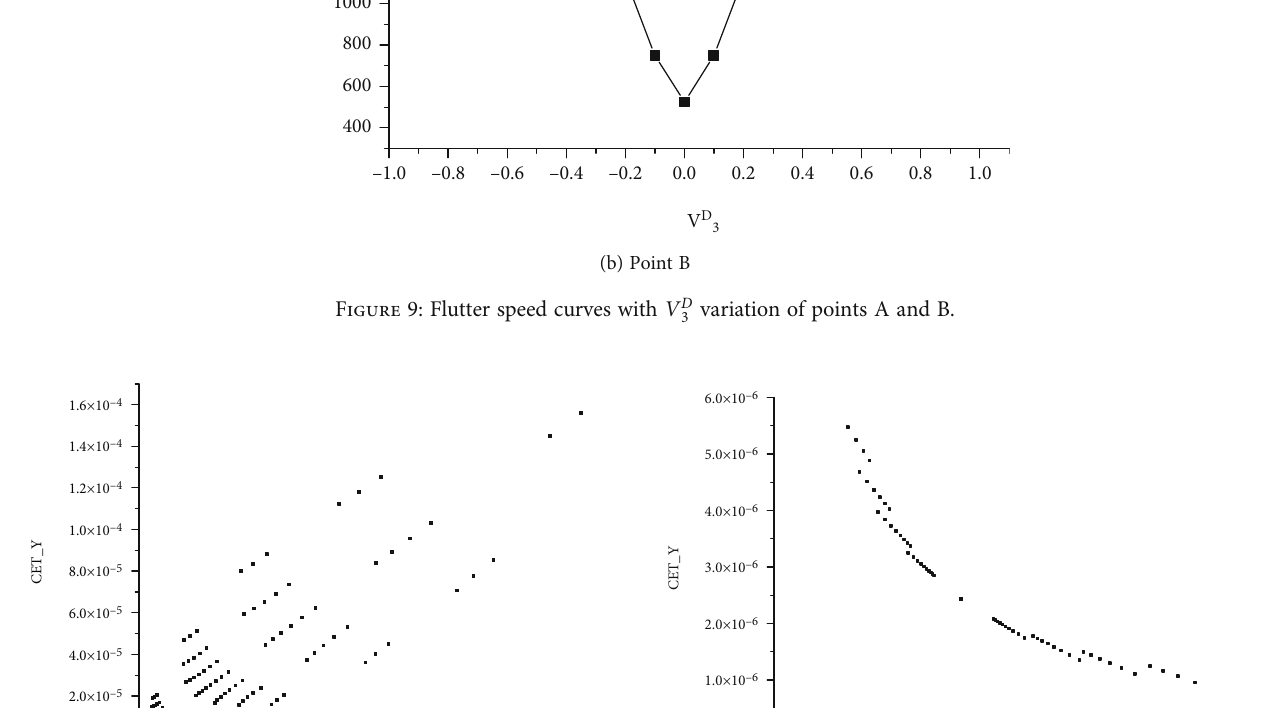
Figure 10: Discrete points of